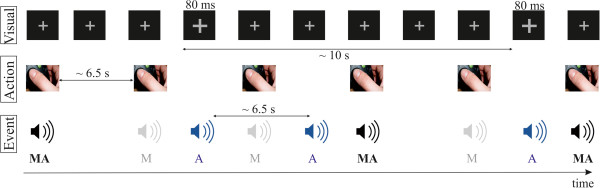
Schematic illustration of the experimental mixed design. Participants were asked to fixate on a grey cross constantly displayed on the center of a black screen. Small extensions of the fixation cross (from a visual angle of 0.69° to 0.74°) were presented for 80 ms duration. The extended fixation crosses were unpredictable in their occurrence using a variable SOA of 5–15 s. Additionally, participants pressed a button approximately every 6.5 s (range 5–8 s). With a probability of 50% button presses were followed by a sound immediately (MA, black). In the remaining 50% button presses were not followed by any sound (M, grey). It was not predictable if the button press would initiate a sound or not. Additionally, externally-produced sounds (with the same physical parameters as the self-initiated ones) occurred randomly between button presses (A, blue). Externally-produced sounds were unpredictable in their occurrence with a variable SOA between 5–8 s (mean of 6.5 s).